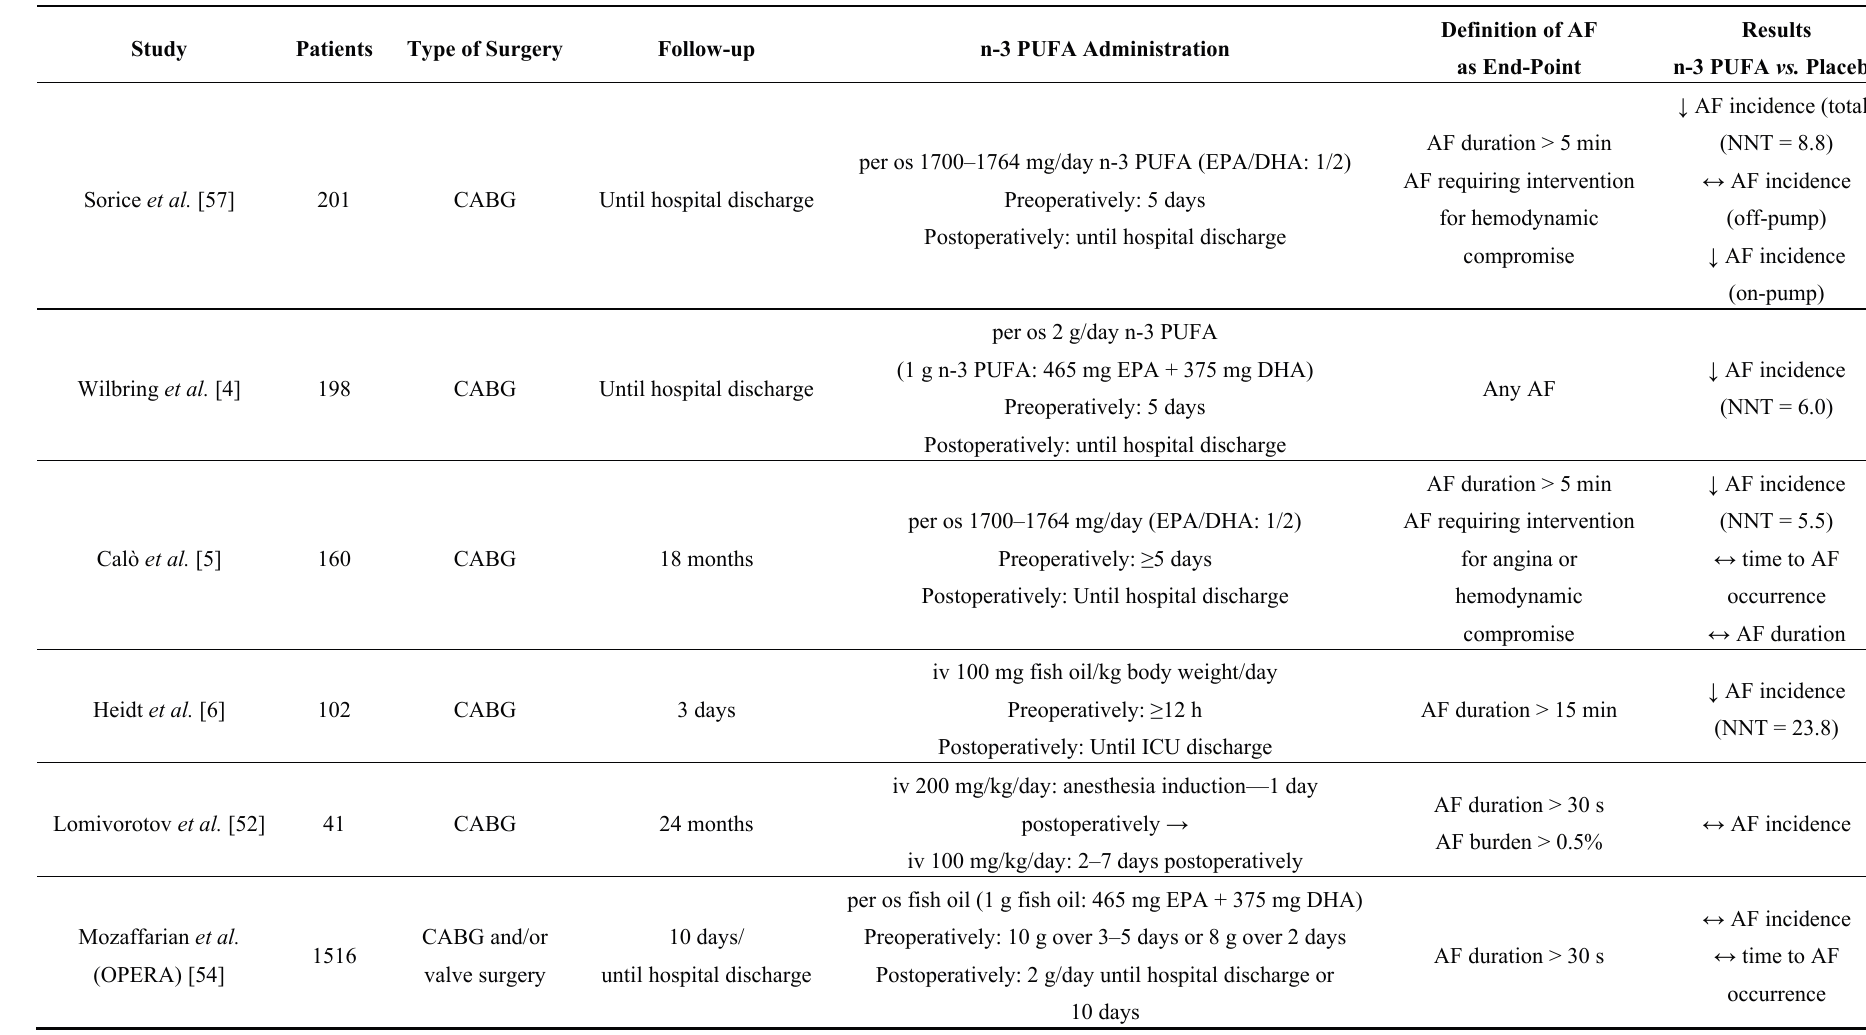
Table 1. The impact of n-3 PUFA supplementation on the prevention of postoperative atrial fibrillation following cardiac surgery. Study Patients Type of